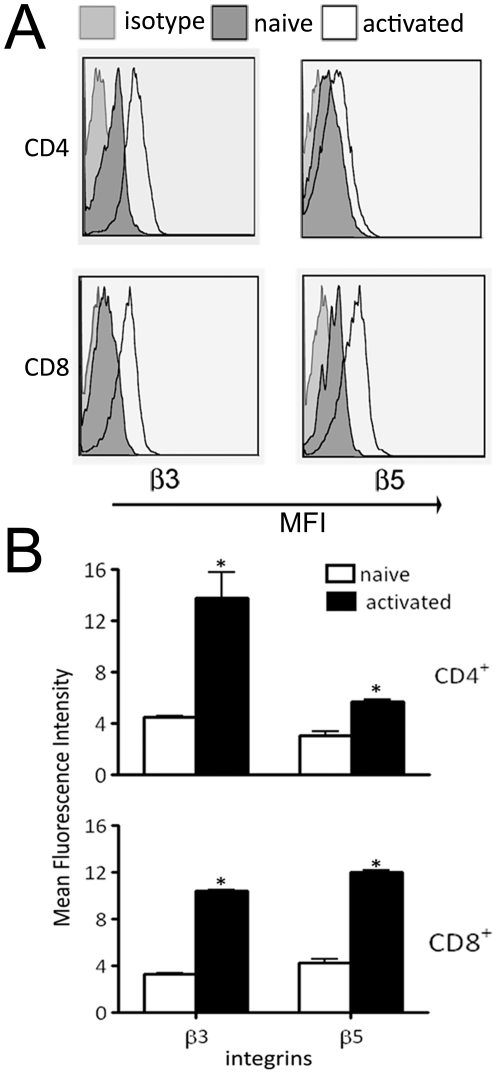
β3 and β5 integrin expression on primary murine T cells.(A) Flow cytometry profile of β3 and β5 integrin expression on naïve and activated primary murine T cells. Left panel shows histograms for β3 integrins on CD4+
(top) and CD8+ T cells (bottom). Right panel shows β5 integrins on CD4+ and CD8+ T cells. (B) Bar diagram representation of β3 and β5 integrin expression on T cells. Top panel shows integrin expression on CD4+ T cells while bottom panel represents CD8+ T cells. White bars indicate naïve T cells and black bars are activated T cells. Error bars indicate mean ± SD. (*p<0.05)